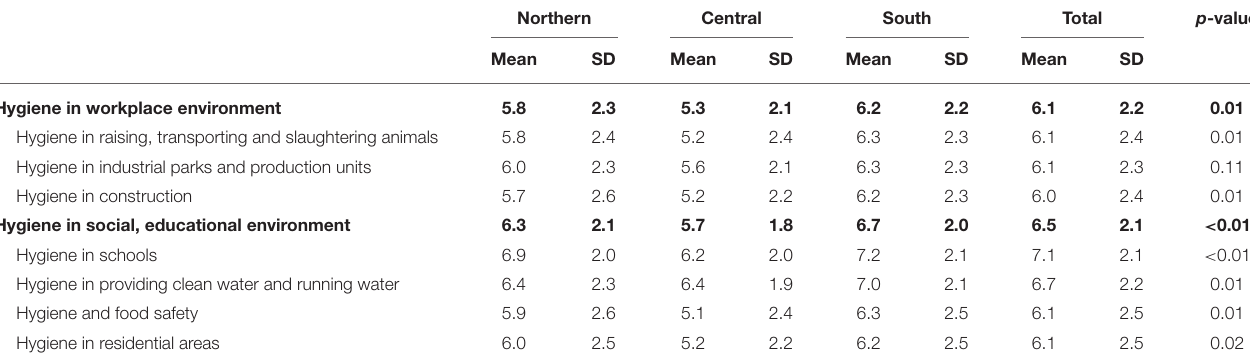
TABLE 3 | Evaluation of hygiene practice in preparedness for disease responses.